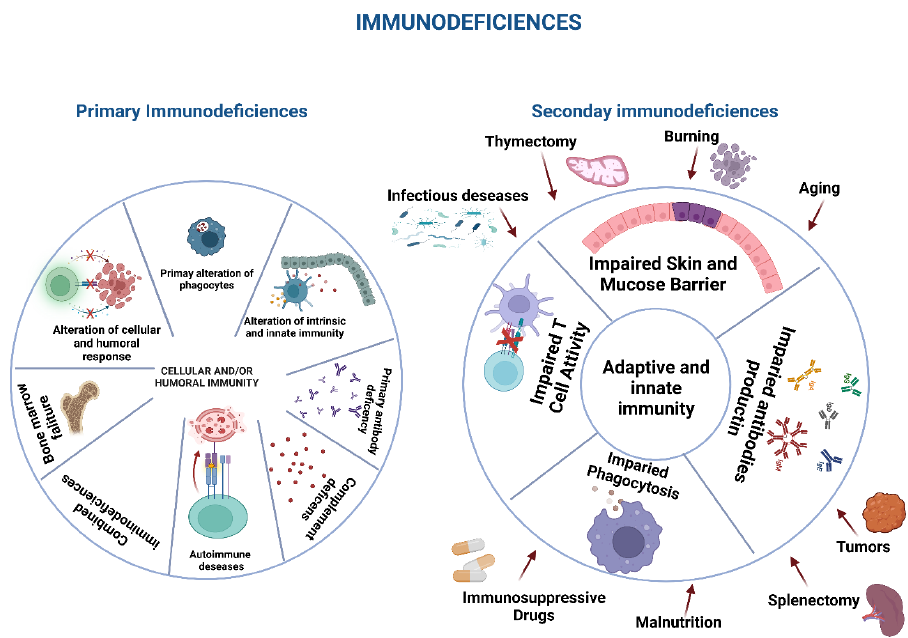
Figure 1. Different aspects of primary and secondary